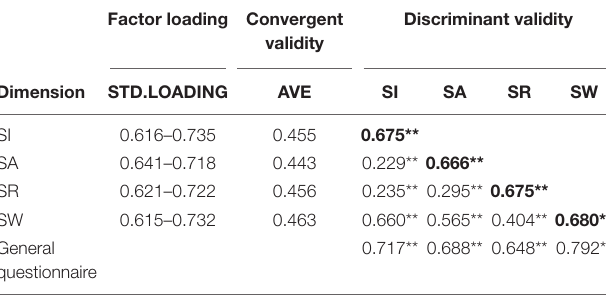
TABLE 3 | Analysis of convergent validity and discriminant validity. Factor loading Convergent validity